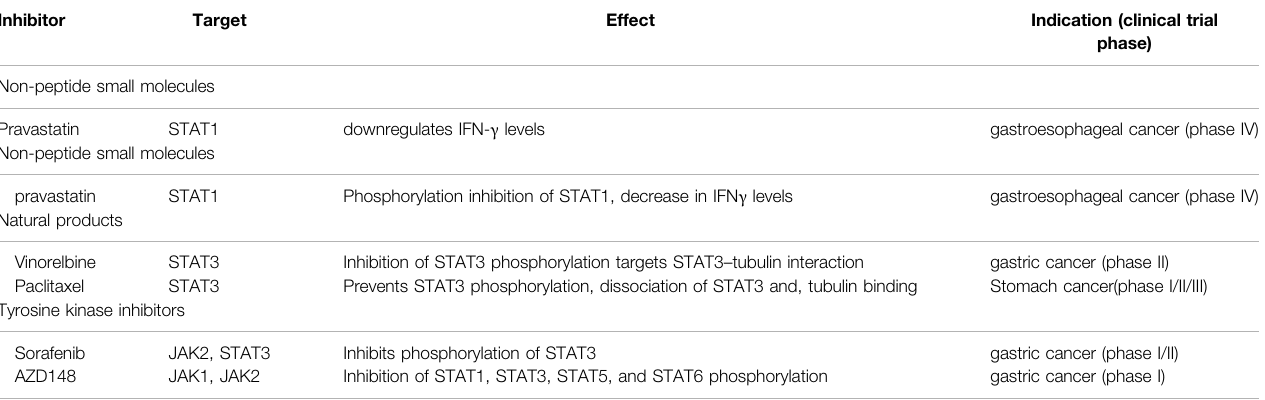
TABLE 2 | JAK/STAT signaling inhibitors, target molecules, effects, and clinical indications in gastric carcinoma. Inhibitor Target